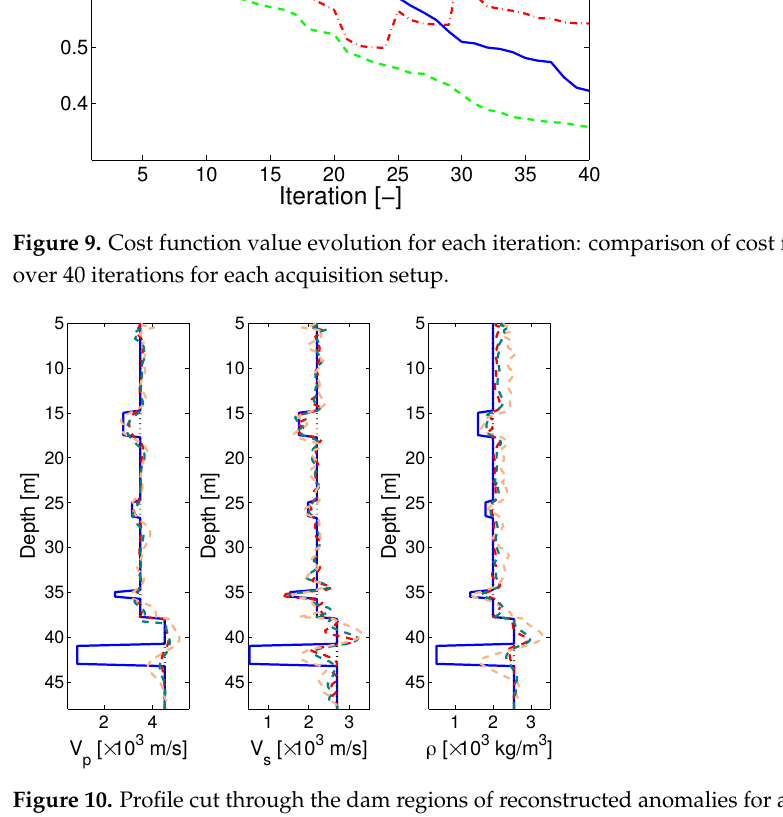
Figure 10. Profile cut through the dam regions of reconstructed anomalies for acquisition setups 1 to 3 showing a comparison between the true model (—), FWI models (dashed lines: - - setup 1, - - setup 2, - - setup 3) and the initial model ( · · ·